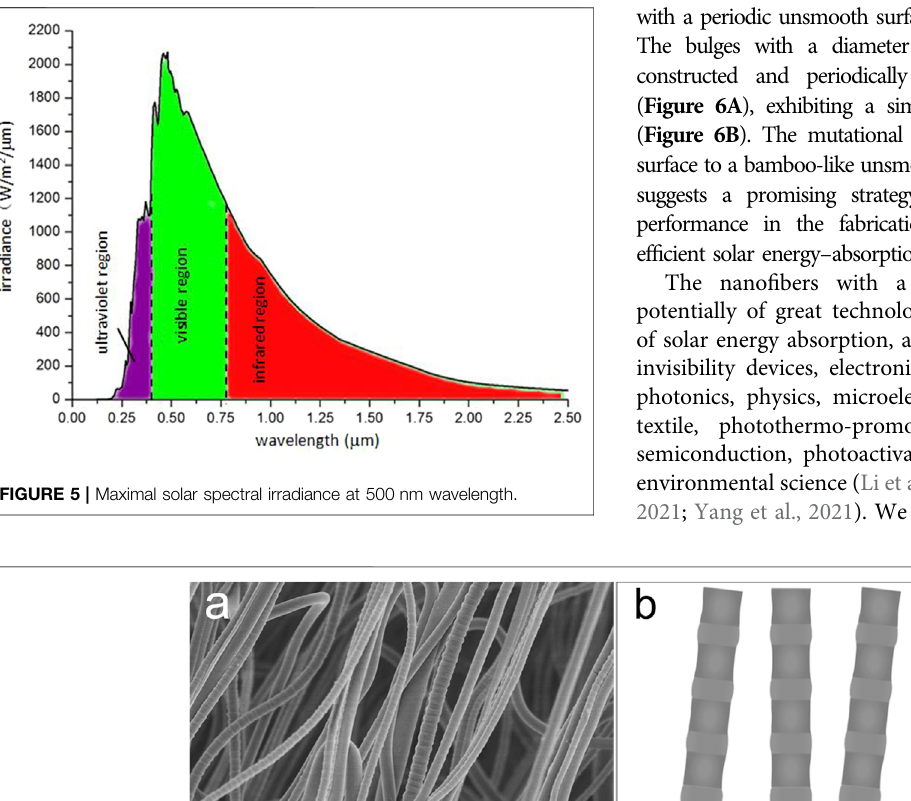
Frontiers in Bioengineering and Biotechnology |